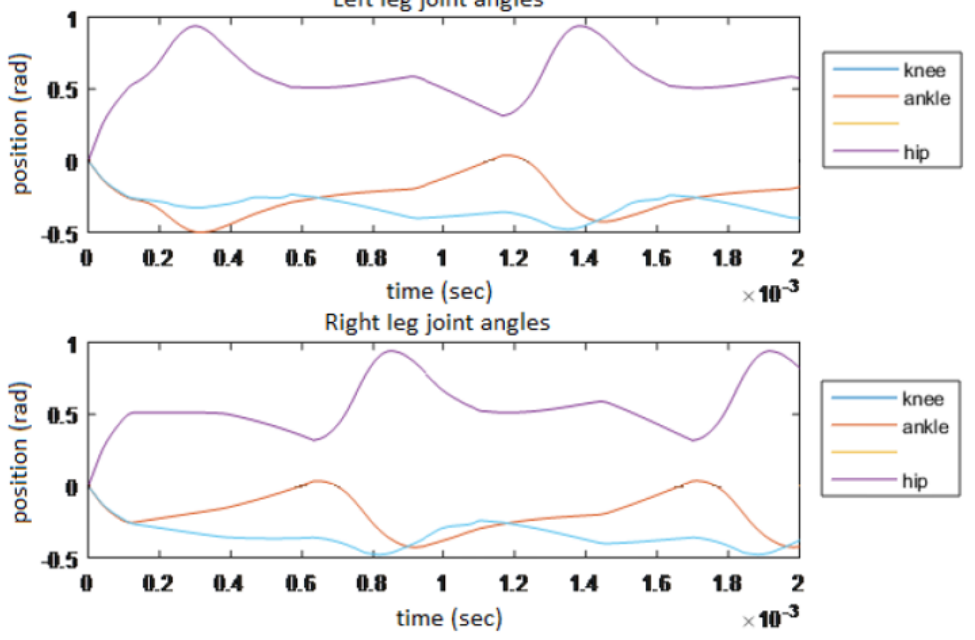
Figure 7. Robot joint angles (knee, ankle and hip pitch angle) for the imposed gait (speed v=0.075 m/s, gait length s=0.08 m, gait height h=0.02 m and friction coefficient µ